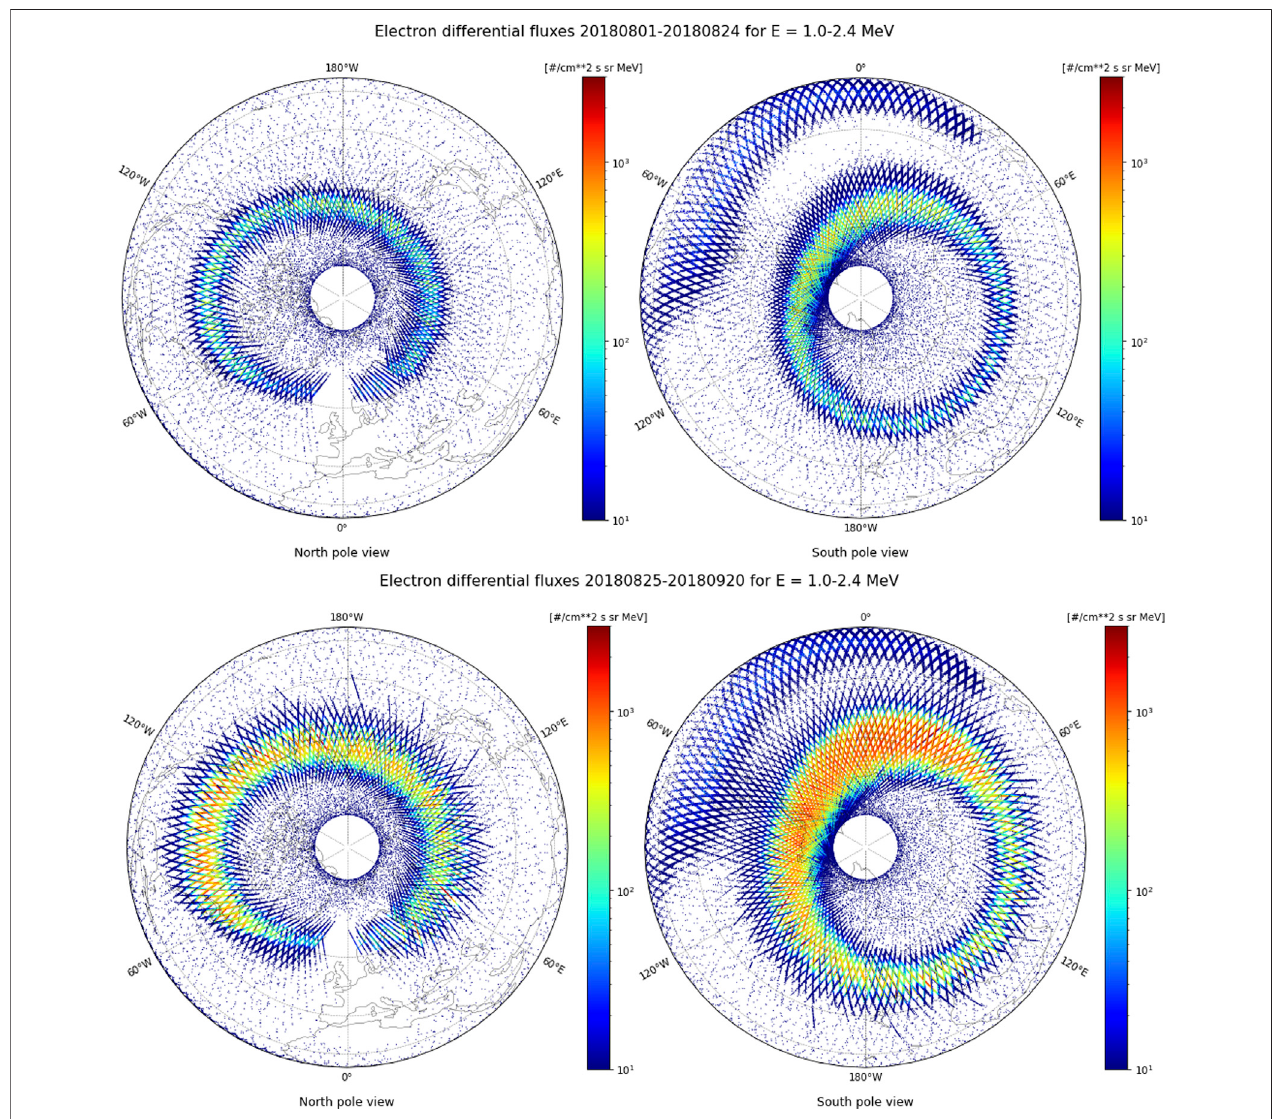
FIGURE14| Mapsofelectrondifferential fl uxmeasuredbyPROBA-V/EPTinChannel5(1 – 2.4 MeV)at820 kmofaltitudeintheNorthernhemisphere (leftpanels) andintheSouthernhemisphere (rightpanels) ,beforethestormfrom1toAugust24,2018 (toppanels) andfrom25AugusttoSeptember20,2018 (bottompanels) during and after thestorm. Thethin blackcircleswith increasingradiuscorrespond toconstant latitudes of80 ° , 60 ° ,40 ° and 20 ° .Greenwich longitudeof0 ° corresponds to the bottom in the Northern hemisphere (left panels) and the top in the Southern hemisphere (right panels) .